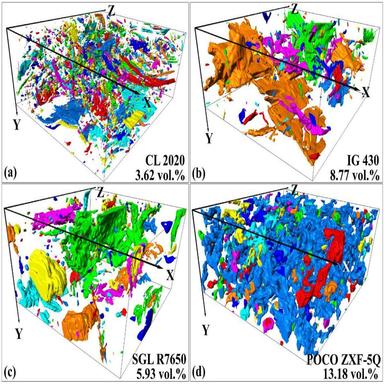
FIB tomography porosity volume 3D rendering images: (a) CL 2020 graphite, total volume: 721 × 271 × 149 voxel3, (b) IG 430 graphite, total volume: 786 × 281 × 149 voxel3, (c) SGL R7650 graphite, total volume: 811 × 351 × 147 voxel3 and, (d) POCO ZXF-5Q graphite, total volume: 771 × 281 × 149 voxel3. Voxel size is 0.023 × 0.030 × 0.133 μm3 for all. Voxel sizes in X and Y directions are different due to the geometric correction in Y direction as described in 2.3 and Appendix 2. Insert values are t